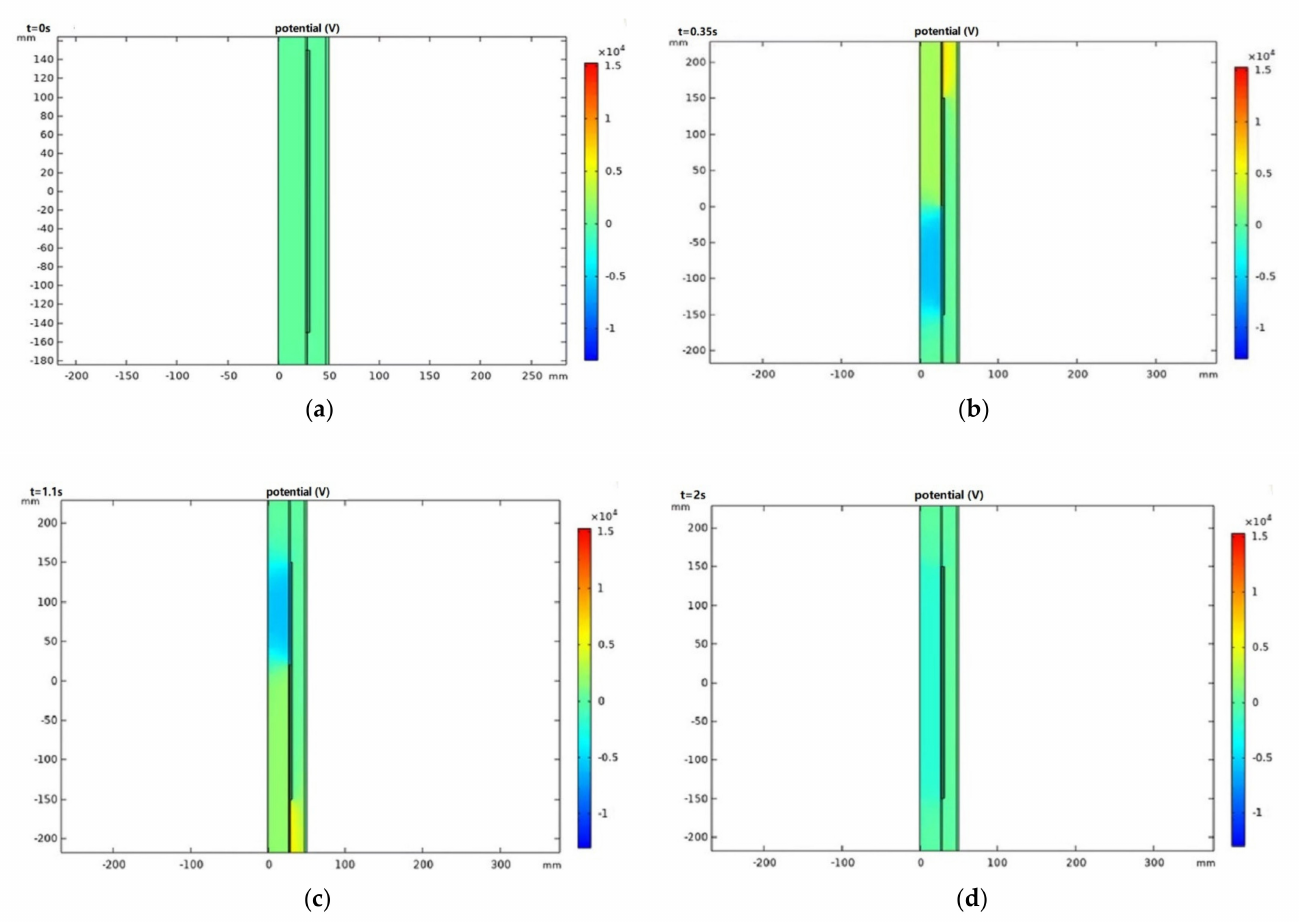
Figure 6. Potential distribution in different stages. ( a ) The sliding electrode at the center ( t = 0 s); ( b ) the sliding electrode at the top ( t = 0.35 s); ( c ) the sliding electrode at the bottom ( t = 1.1 s); ( d ) the sliding electrode back to the center ( t = 2 s).